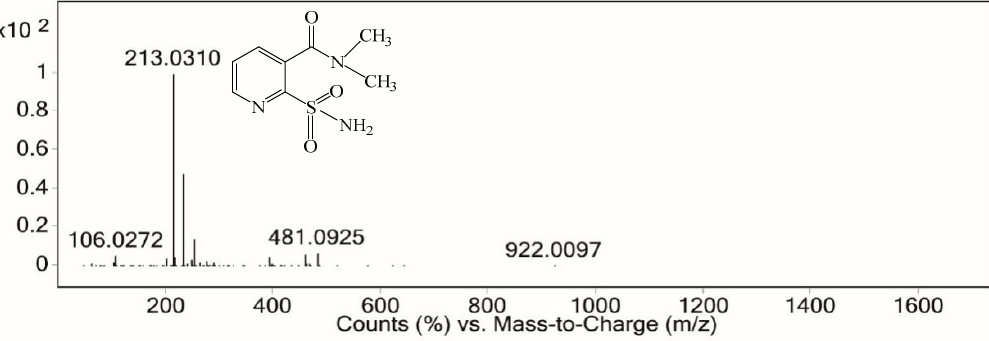
Figure 13. ESI spectrum from 4.767 min to 4.850 min.